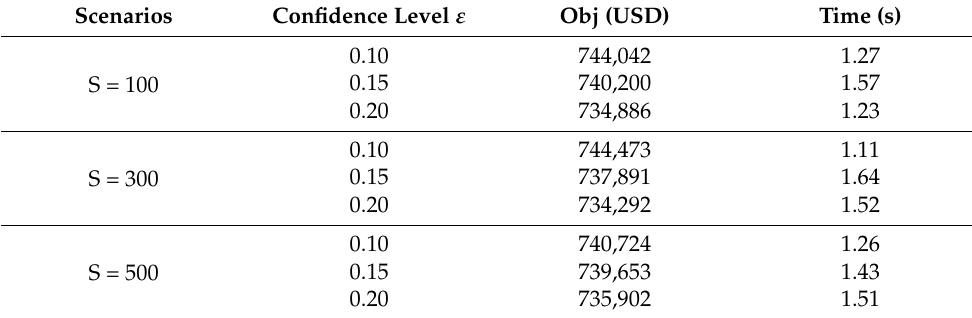
Table 1. Comparison of total system costs under different confidence levels.